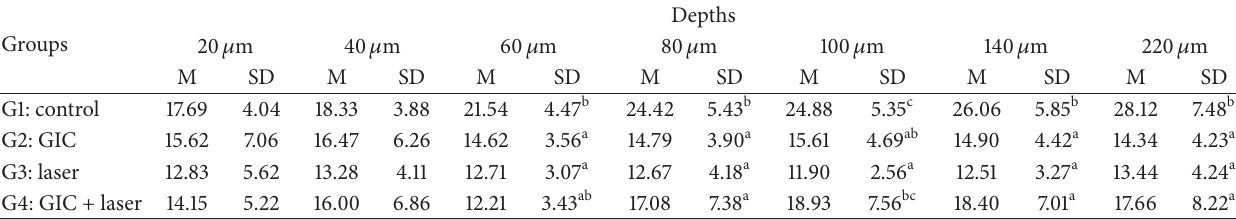
Table 2: Microhardness analysis means (M) and standard deviations (SD) for all groups tested (similar letters indicate statistical similarity). Groups